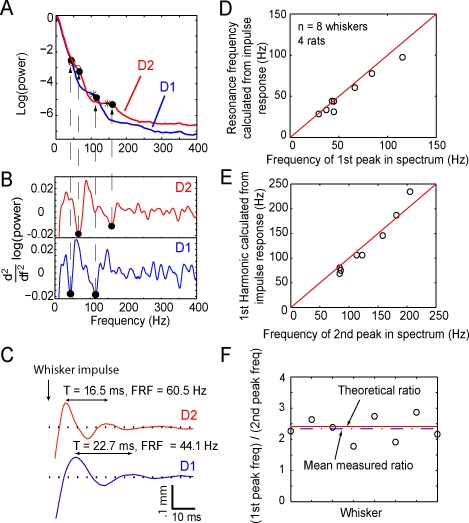
Whiskers Preferentially Vibrate at Resonance Frequency during Whisking in Air(A) Power spectra of whisker motion during whisking in air for the D1 and D2 whiskers of rat N2. Filled circles denote shoulders, identified as the points of maximum negative concavity (minima in the second derivative of the power spectra). Open circles and asterisks show the FRF and calculated first harmonic (respectively), measured by the impulse method in the anesthetized animal, after the behavioral recording session.(B) Second derivative of the power spectra in (A).(C) Impulse method for measuring FRF in the anesthetized animal, for the whiskers in (A). FRF is calculated from the period (T) of ringing after delivering a sharp impulse.(D) Relationship between FRF calculated by the impulse method and first peak of the power spectrum during whisking in air, for eight whiskers in four rats performing the nose poke task.(E) Relationship between calculated first harmonic of the FRF, measured by impulse method, and the second peak of the power spectrum during whisking in air.(F) Measured ratio of first peak to second peak in the power spectrum during whisking in air, for eight whiskers in four rats performing the nose poke task. Dashed line indicates the mean ratio. Solid line indicates the theoretical value of 2.41 for f
1/FRF ratio for a conical beam.